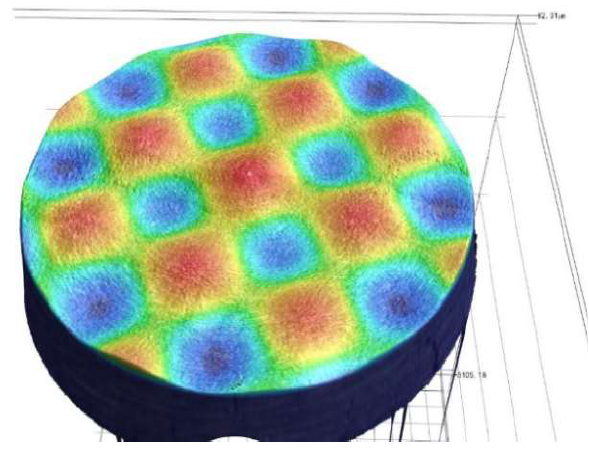
Figure 19. The surface topography of compound sinusoidal surface.